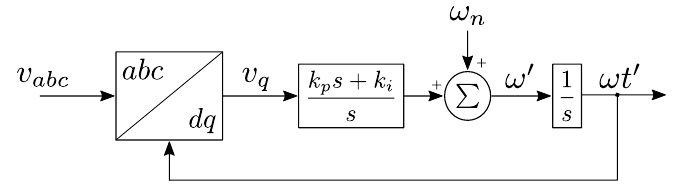
Figure 1. Block diagram of the